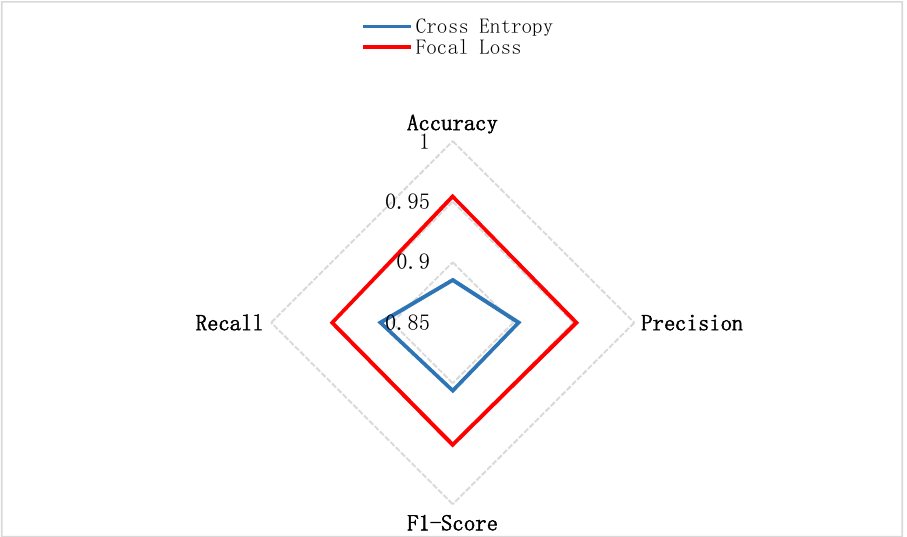
Figure 14. Performance Comparison of Cross-Entropy and Focal Loss Functions.